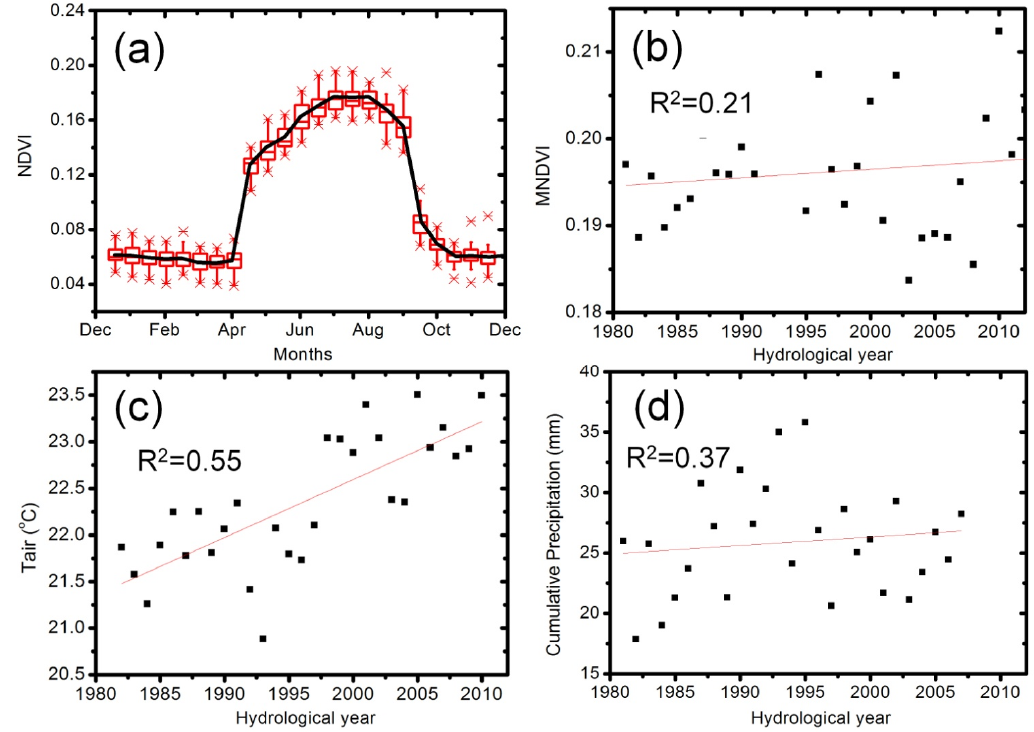
Figure 3. ( a ) Box chart of the monthly mean NDVI of the 22 years from 1981 to 2012 in LHRB and ( b ) the maximum NDVI (MNDVI); ( c ) average air temperature; and ( d ) cumulative precipitation between June and September from 1981 to 2012 in